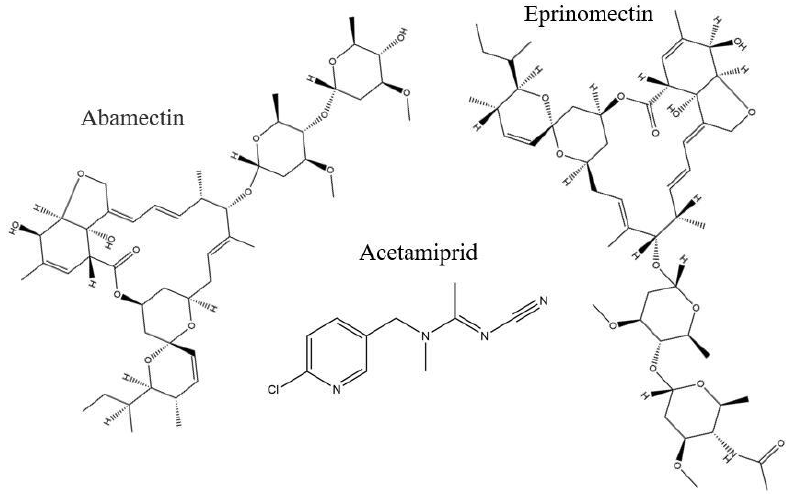
Figure 1. Chemical structures of abamectin, acetamiprid, and eprinomectin.